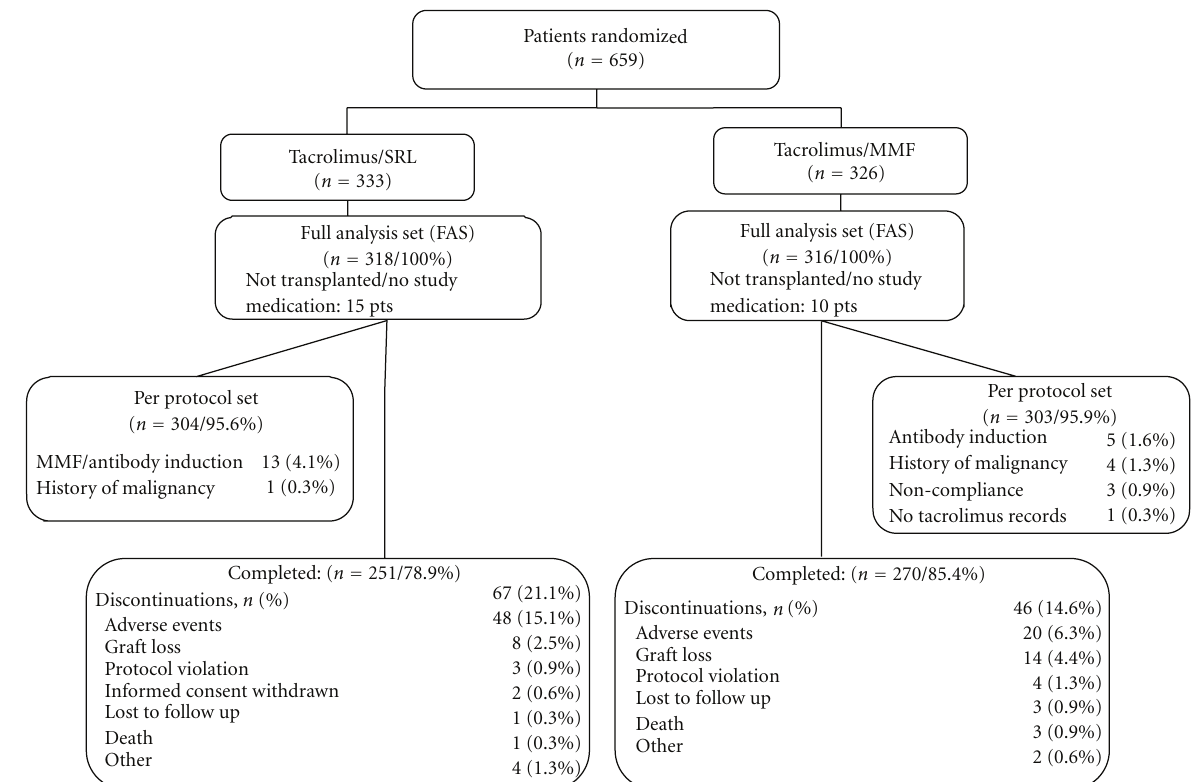
Figure 1: The full analysis set, which consisted of all patients who received at least one dose of study drug, included 318 patients in the Tac/SRL group and 316 patients in the Tac/MMF group. More patients in the Tac/SRL group withdrew from the study prematurely, the majority because of an adverse event.